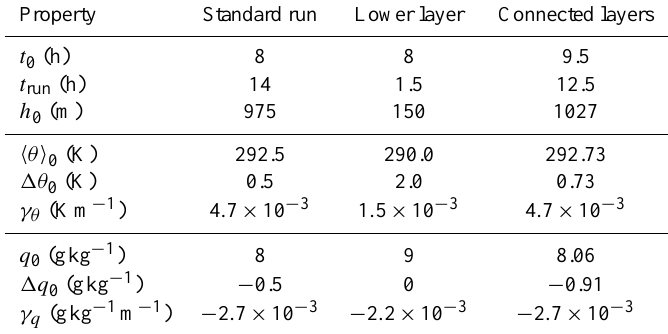
Table 6. The prescribed initial values (subscript 0) and free tropospheric gradients, γ , for three different numerical experiments with the MXL model. The initial time, t 0 , is expressed in hours local daylight saving time and the runtime of the model is expressed by t run in